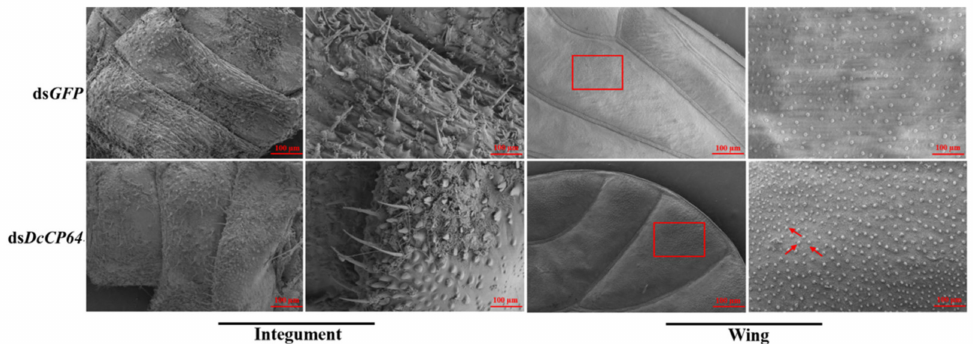
Figure 7. Microstructural analysis of D. citri wing and cuticle after RNAi of DcCP64 by SEM. The red box indicates the differences in surface structure. The red arrows indicate the spiny trunk on D. citri surface of the